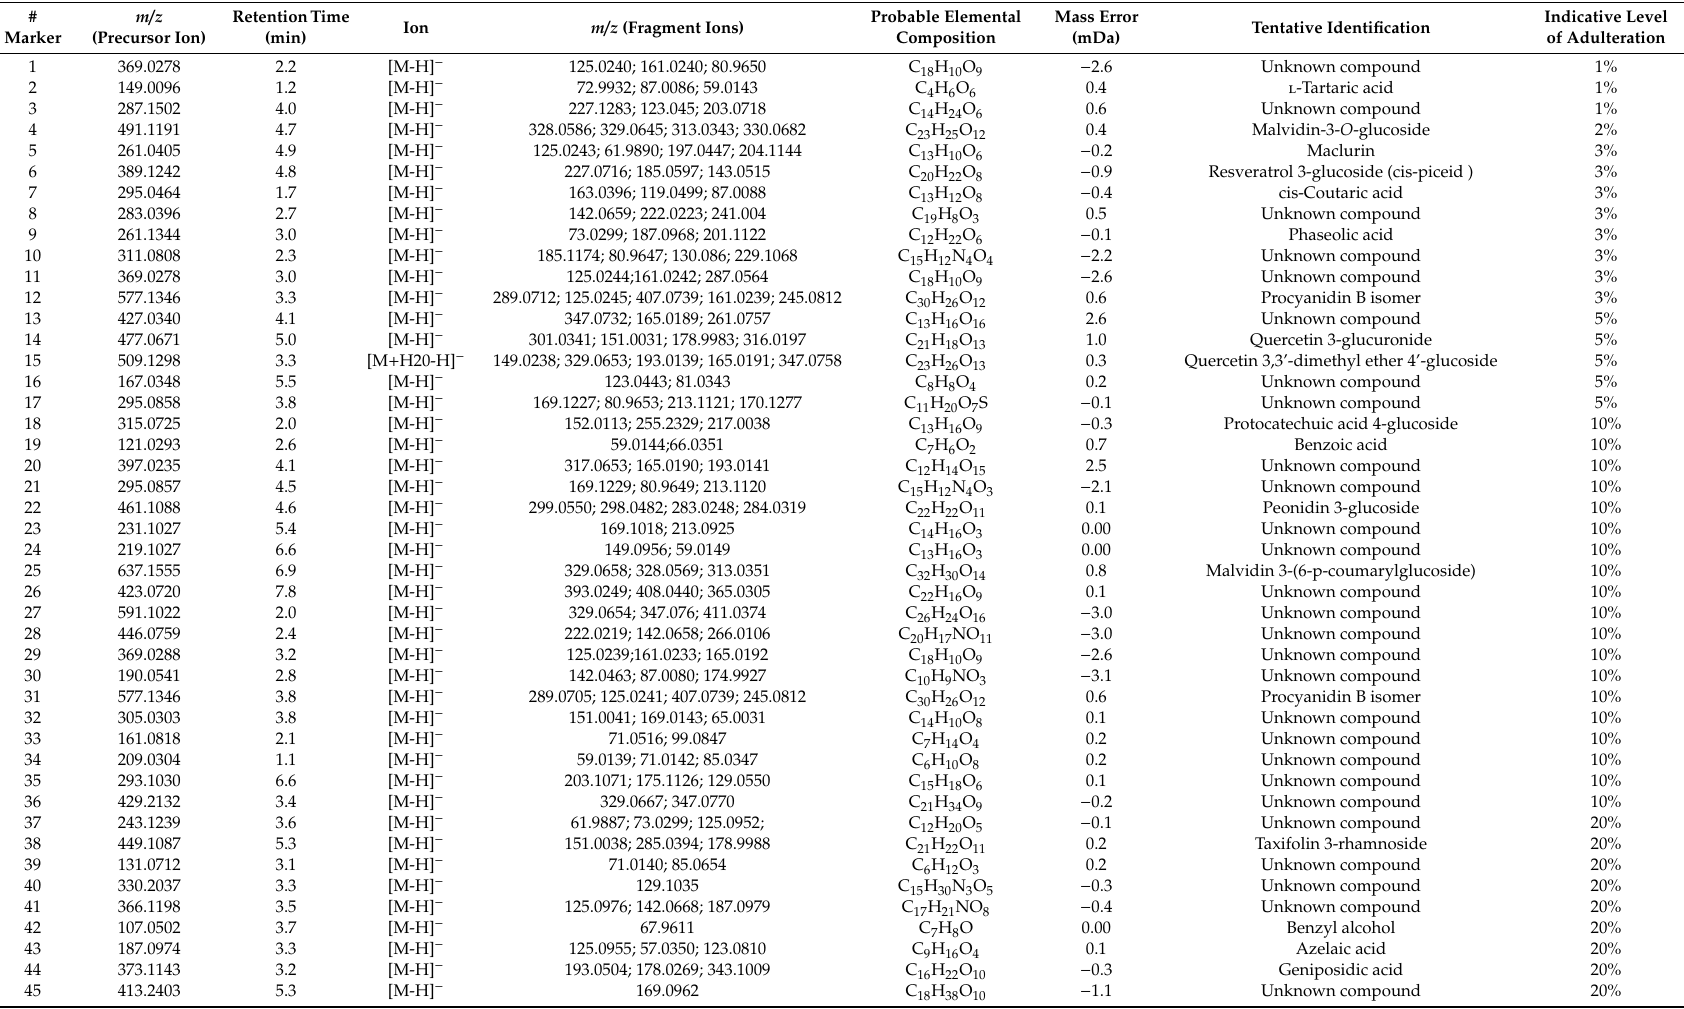
Table 4. Tentative identification of characteristic marker compounds indicating pomegranate juice adulteration from red grape